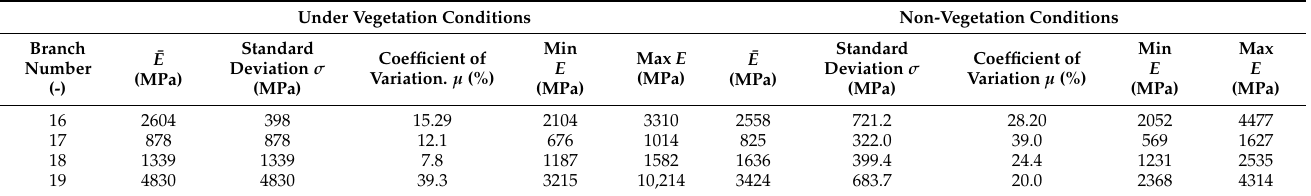
Table 8. Summary of calculated modulus of elasticity for individual branches of shrub No. 3 under vegetation and non-vegetation